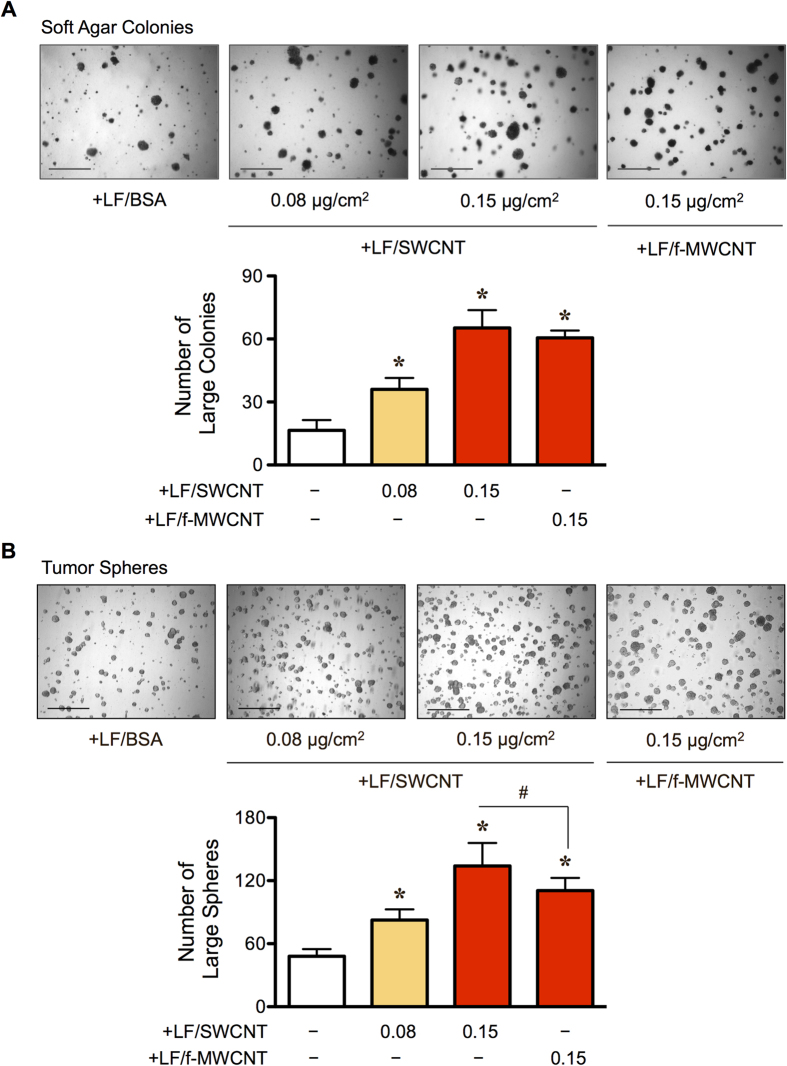
Carbon nanotube-induced cancer-associated fibroblast-like cells promote the growth and maintenance of cancer stem cells.Carbon nanotube-induced cancer-associated fibroblast-like cells (LF/SWCNT or LF/f-MWCNT) or vehicle-treated fibroblasts (LF/BSA) were co-cultured with GFP-labeled lung cancer H460 cells (2:1 ratio). (A) Analysis of soft agar colonies after 2 weeks of culture. Scale bar = 200 μm. (B) Analysis of tumor sphere formation after 2 weeks of culture. Scale bar = 300 μm. Data are mean ± SD (n = 4). *P < 0.05 vs H460 and LF/BSA group. #P < 0.05 vs H460 and LF/SWCNT group.